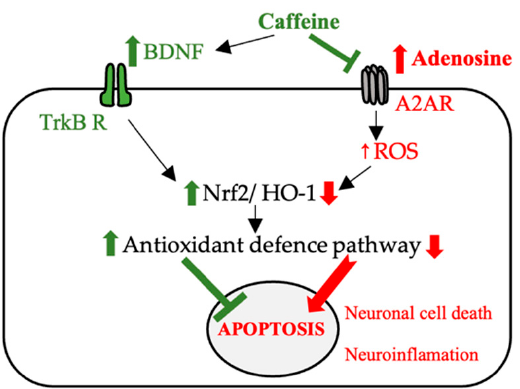
Figure 4. The possible mechanisms involved in the neuroprotective effect of caffeine (BDNF—brain- derived neurotrophic factor, TrKB R—tropomyosin receptor kinase B, Nrf2—nuclear erythroid 2- related factor, A2AR—adenosine receptor, HO-1—heme oxygenase-1, ROS—reactive oxygen species). In preclinical studies, caffeine has demonstrated a protective effect against the oc- currence of neural damage produced after administration of d-galactose [52], cadmium (Cd) [53], lipopolysaccharides (LPS) [54], or exposure to hyperoxia [55]. The doses of pure